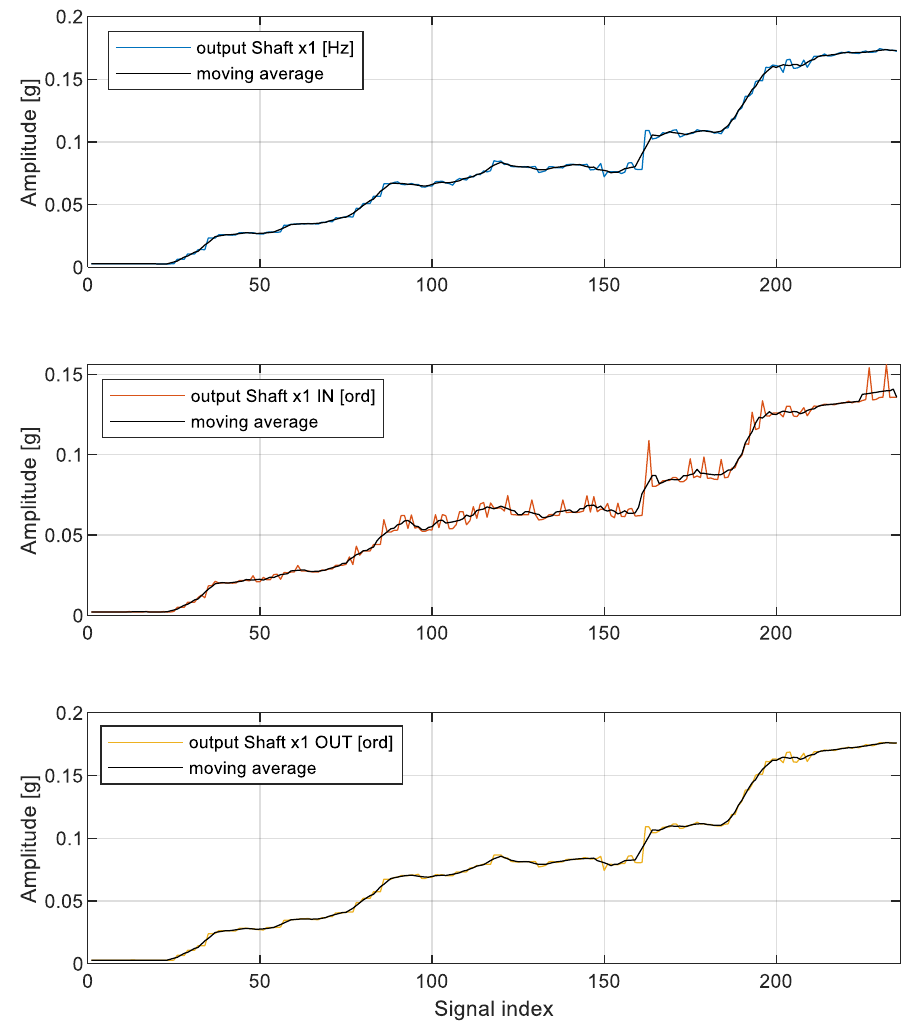
Figure 11. Graphical illustration of moving average value for individual scalar health indicators. Abscissa is the same as in Figures 9 and 10. Table 2. Quantitative assessment of narrowband health indicators.